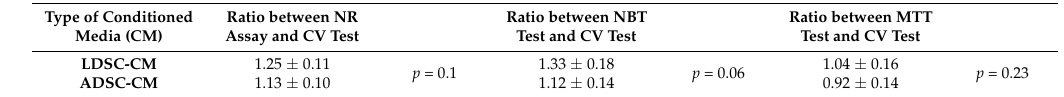
Figure 3. Macrophages’ response to LDSC-conditioned media (CM) and ADSC-CM evaluated by neutral red (NR) assay ( a ), NBT test ( b ), MTT test ( c ) and crystal violet (CV) test ( d ); mean ± standard deviation (SD); n(LDSCs) = 5 and n(ADSCs) = 4 (n − number of patients per group); for each patient sample culture-derived CM, as well as control culture, four to eight replicates were analyzed in each assay; (*) p < 0.05 (compared to standard medium). Table 1. NR uptake, NBT and MTT reduction normalized to the cell number obtained by CV test for each sample; results are presented as mean values ± standard deviation (SD).